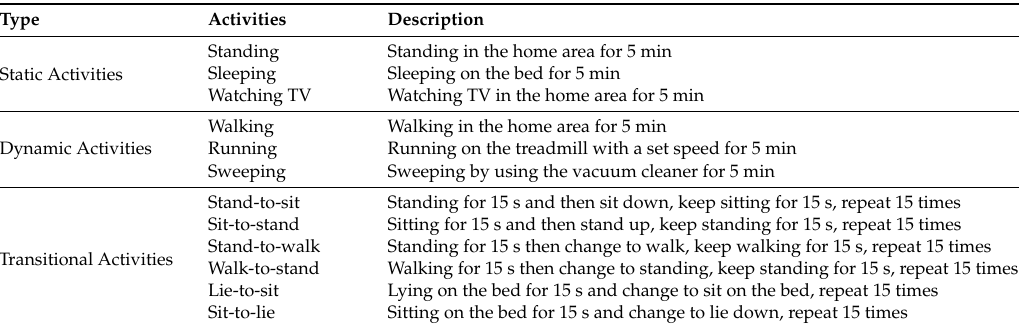
Table 1. The taxonomy and brief description of monitored